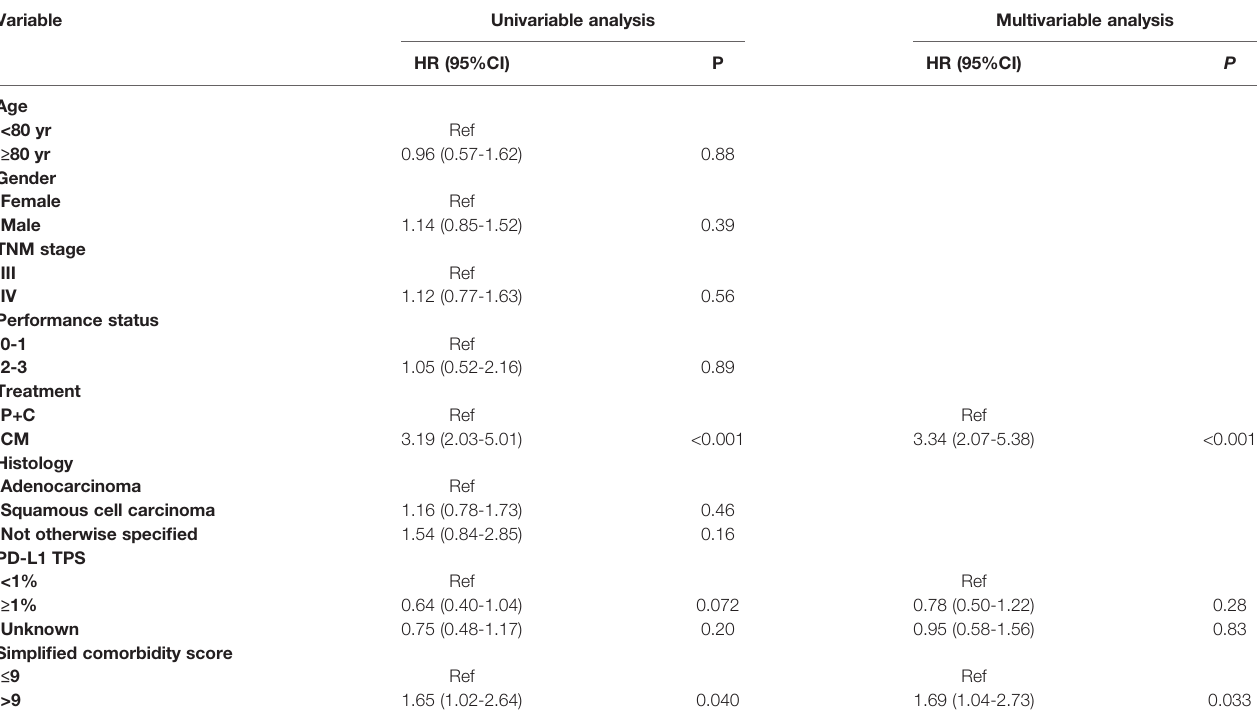
TABLE 2A | Univariable and multivariable analysis on disease-free survival.